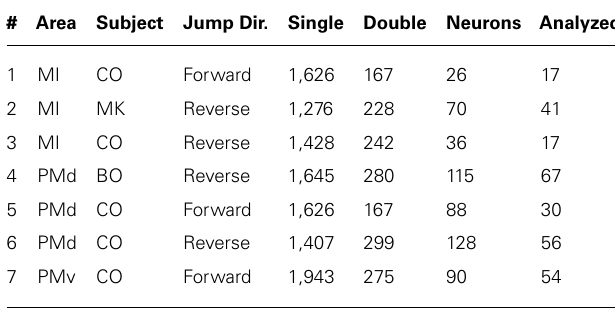
user-defined threshold were classified as spikes belonging to that